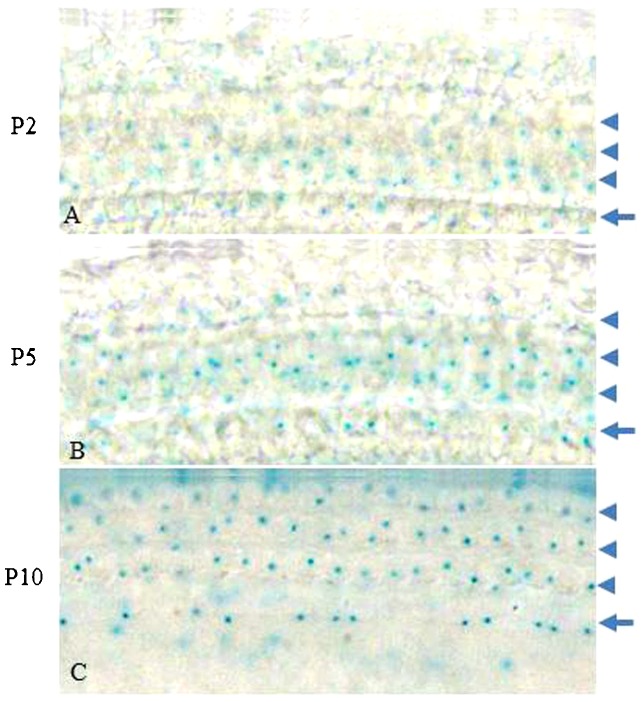
X-gal staining for beta-galactosidase activity in the organ of Corti in P2 (A), P5 (B), and P10 (C) Ildr1+/− mice.Arrowheads in A–C point to the three lines of outer hair cells and arrows in A–C point to the single line of inner hair cells.